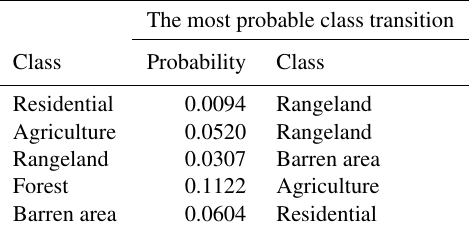
Table 2. Study area Markov chain probabilities (1985–2014).